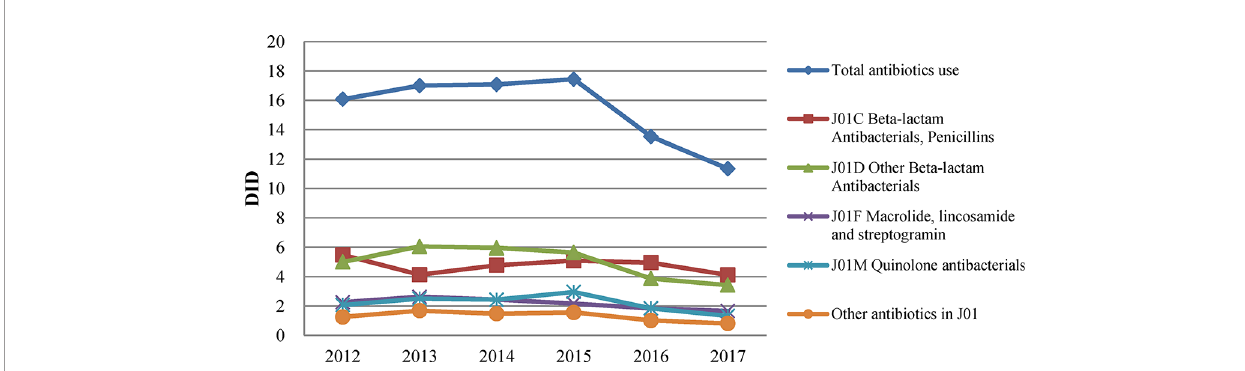
FIGURE 1 | Antibiotic consumption in Shandong, China, 2012 – 2017.